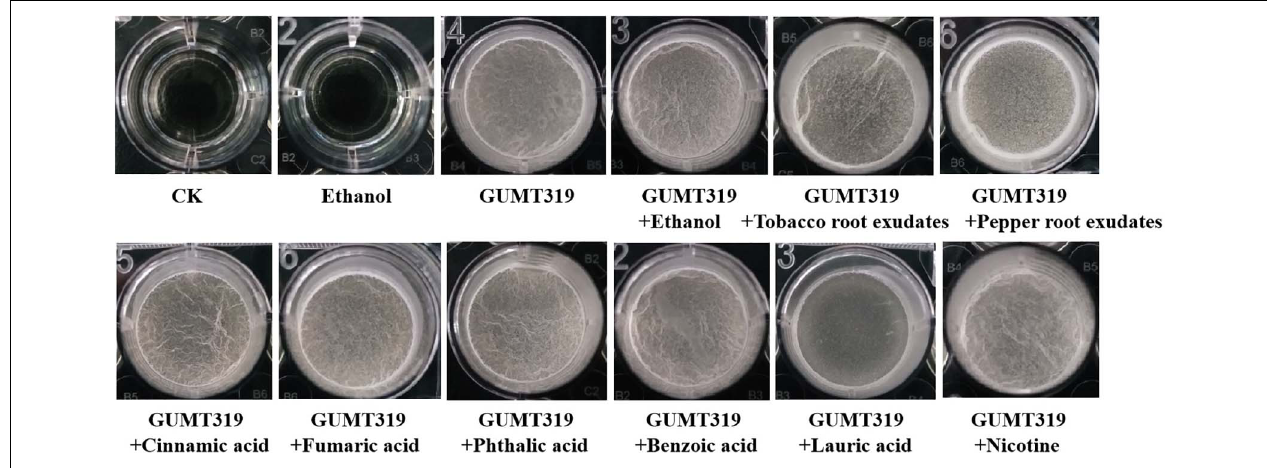
FIGURE 6 | Biofilm formation assay of B. velezensis GUMT319.